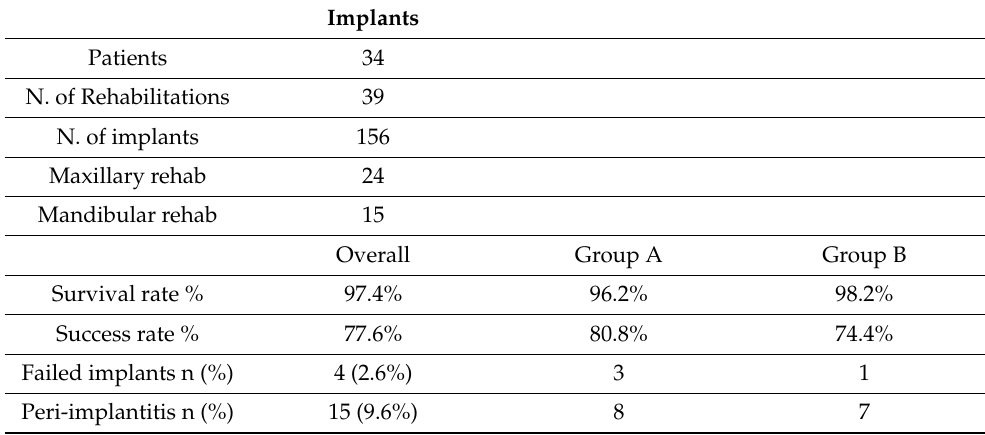
Table 1. Population